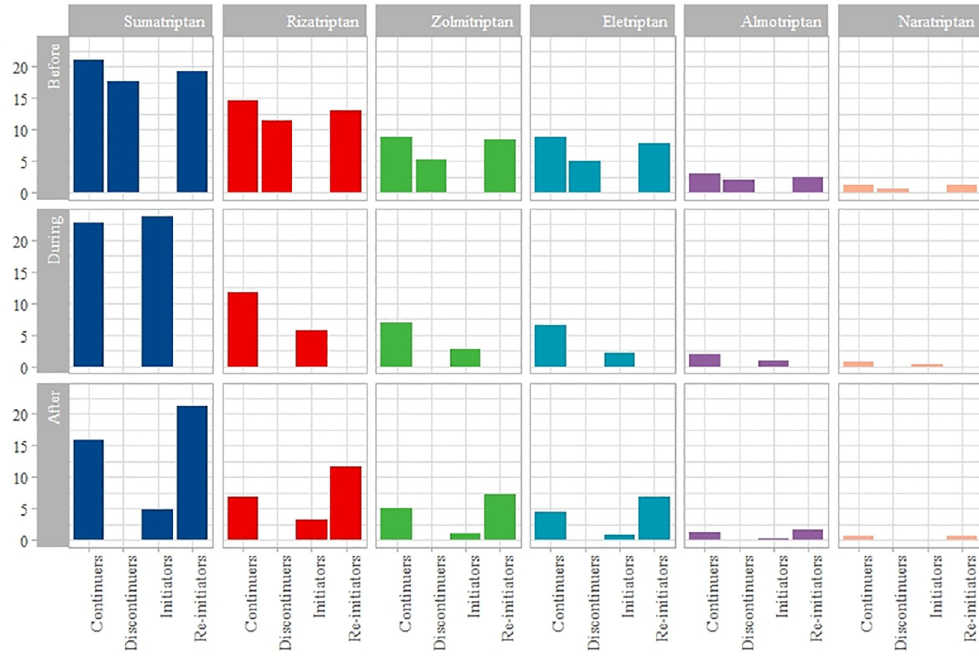
Fig 2. Proportion of pregnancies with filled prescriptions for different triptans according to timing in pregnancy and triptan utilization group (n = 22,940). Sum of percentages is greater than 100% because some women used several types of triptans. Before = one year before pregnancy, during = during pregnancy, after = one year after pregnancy. https://doi.org/10.1371/journal.pone.0256214.g002 sumatriptan prescriptions during pregnancy (23.7%), followed by a rapid decline after preg- nancy (4.9%). The proportions were similar before (19.3%) and after (21.2%) pregnancy for re- initiators (Fig 2). The continuers used a higher proportion of other triptans during pregnancy than the initiators. The re-initiators used the highest proportion of triptans after pregnancy. As presented in Table 3, during pregnancy, extended use of triptans occurred in 6.9% of the continuers in T1. They had higher median DDDs than initiators during pregnancy (18 vs 6 DDDs). We also found a higher mean number of triptan prescriptions filled in pregnancy among the continuers (1.9 prescriptions) compared with the initiators (1.3 prescriptions). In Table 3. Drug utilization parameters for triptan use among exposure groups during and after pregnancy, 2006–2017 (n = 22,940). Parameters Discontinuers Continuers Initiators Re-initiators Pre Pre During Post During Post Pre Post Extended use of triptans � , n